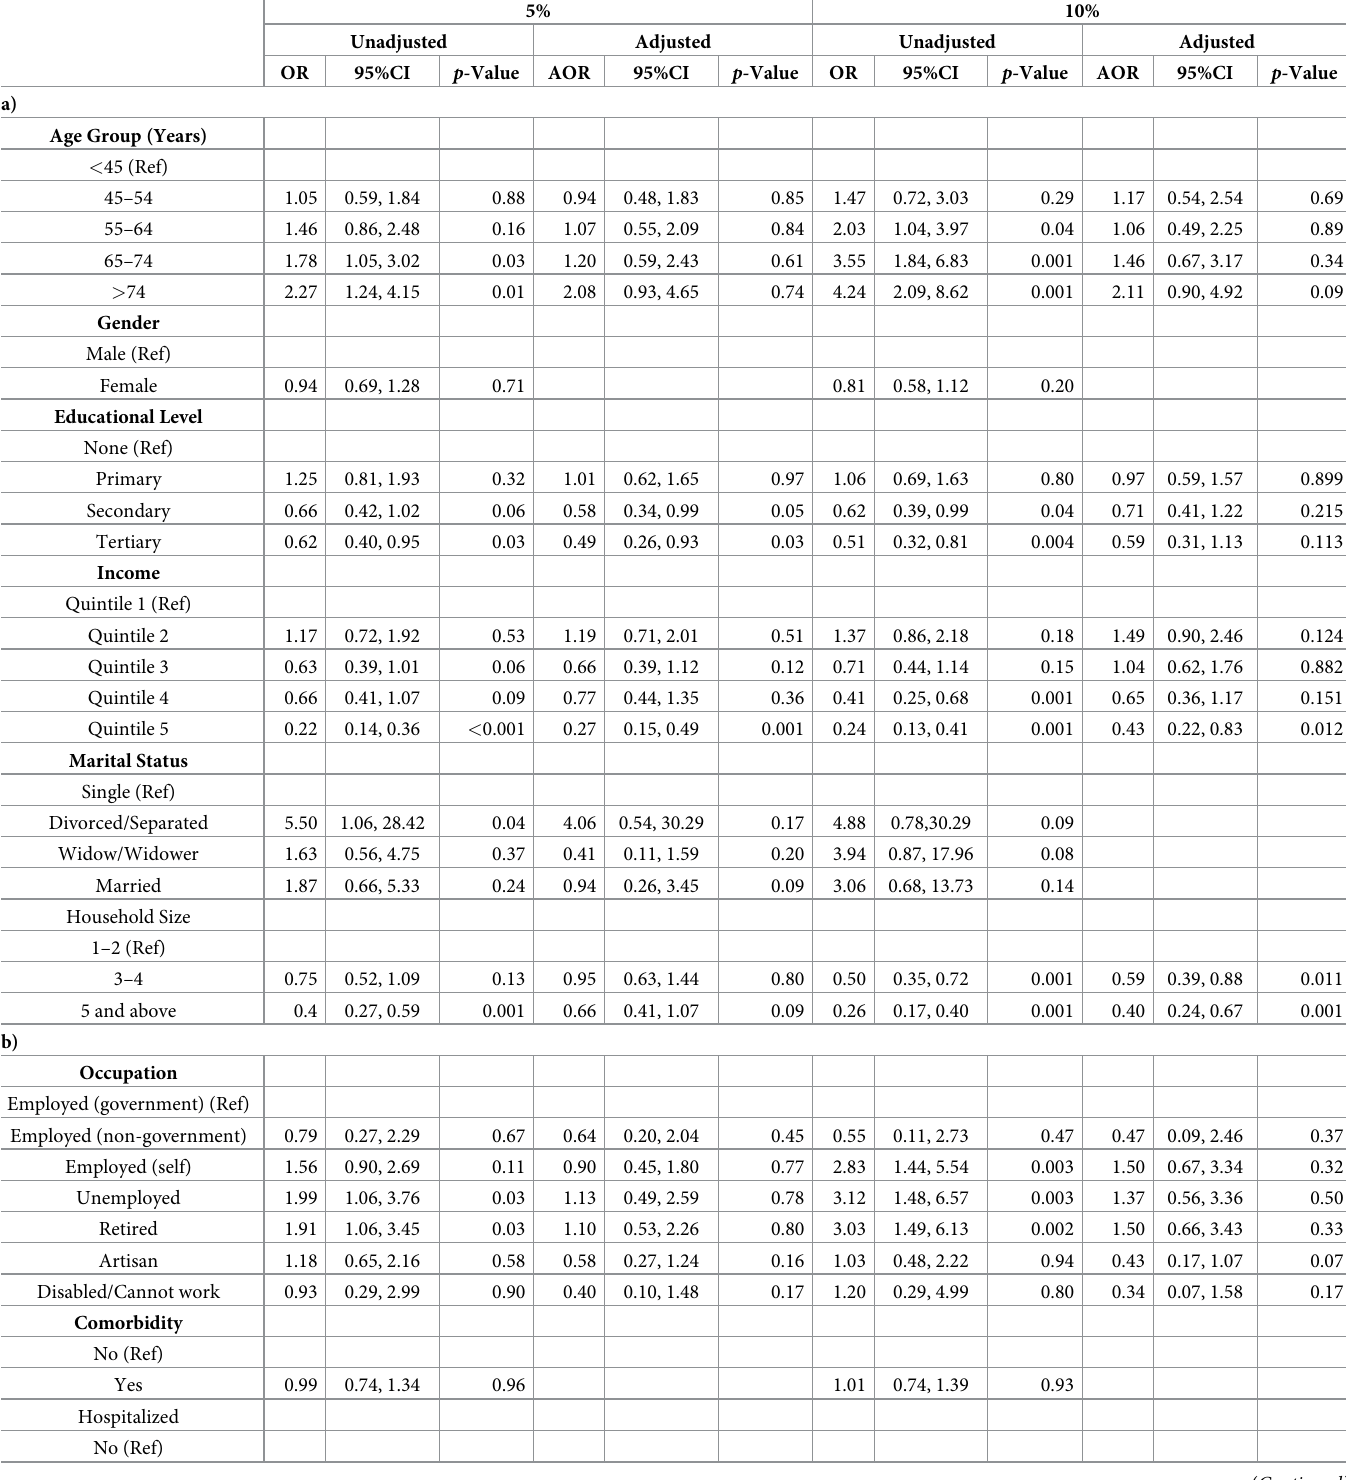
Table 5. Unadjusted and adjusted logistic regression of the factors associated with catastrophic health expenditure among the households of CVDs patients access- ing healthcare in public and private hospitals in Ibadan (N = 744). 5% 10% Unadjusted Adjusted Unadjusted